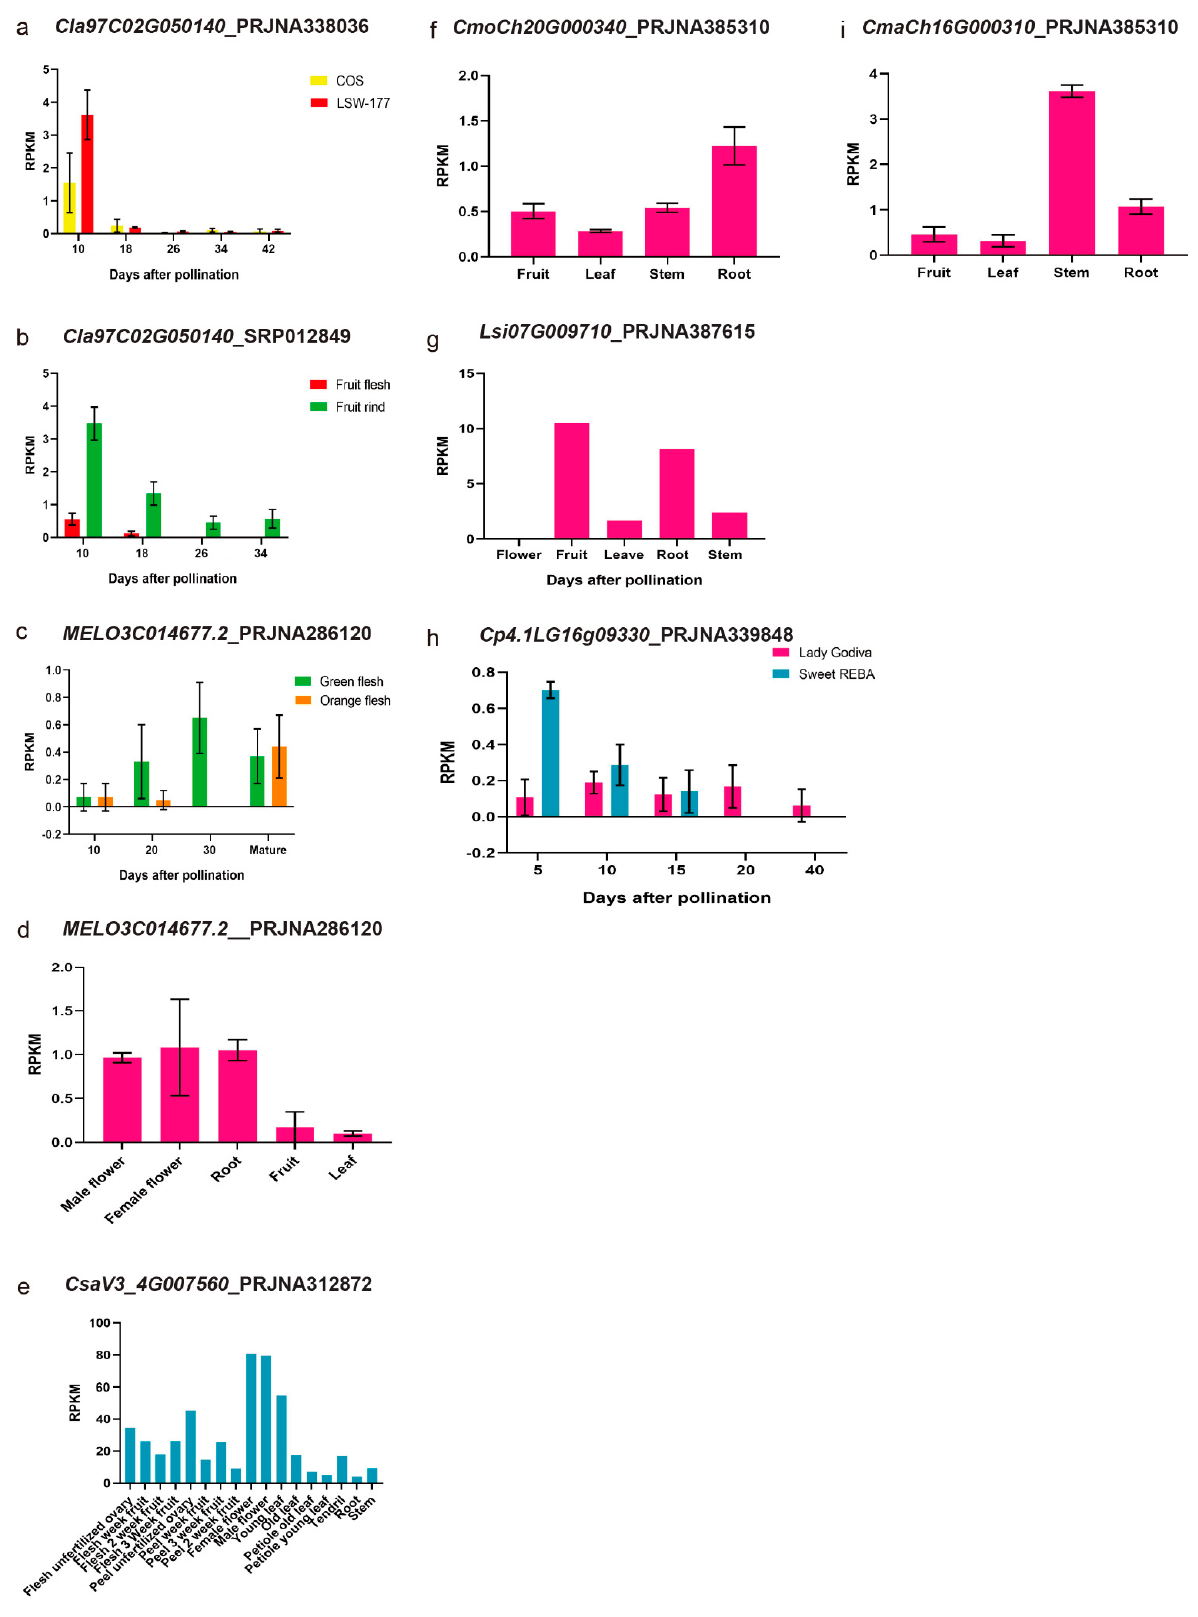
Figure 8. ClPSY2 homologous genes expression pattern analysis with the published RNA-seq data. ( a – i ): RPKM of PRJNA338036, SRP012849, PRJNA286120, PRJNA312872, PRJNA385310, PRJNA387615 and PRJNA339848.